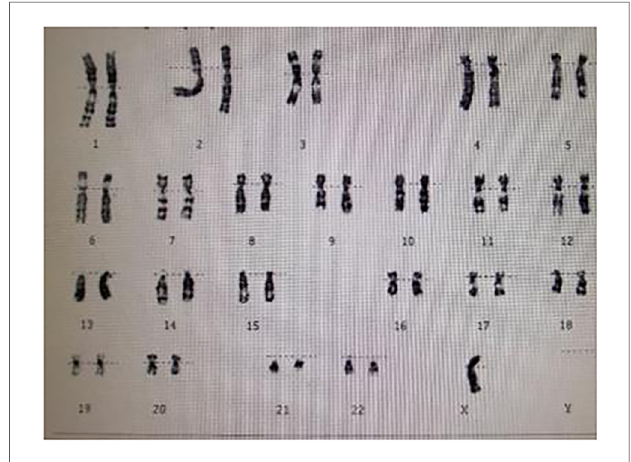
FIGURE 1 Karyotype analysis showing a pure 45, X karyotype.